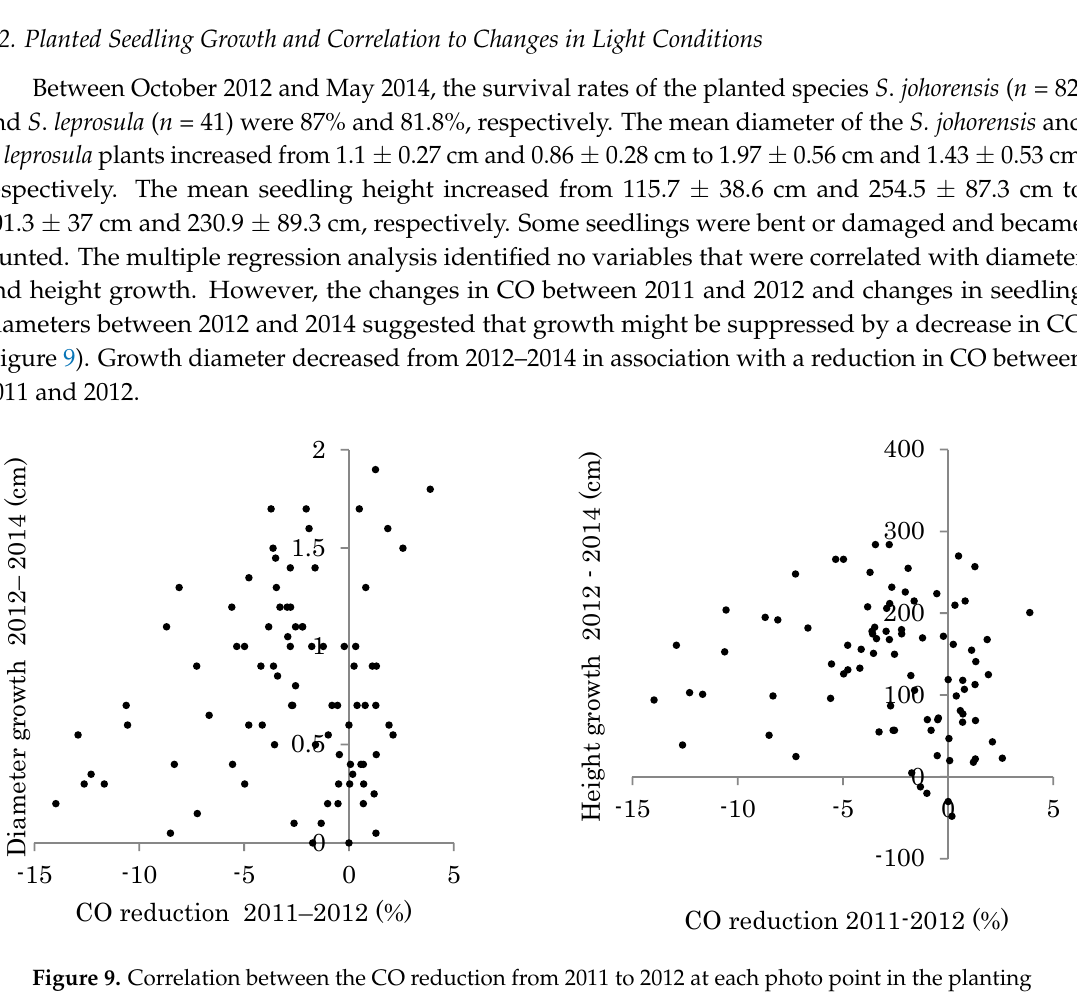
Figure 8. The positions of all trees > 1 cm diameter at breast height (DBH) in 2011 (filled dots) and seedlings that were newly established up to 2012 (blank dots) in a 20 × 100 m line transect set along a planting line.